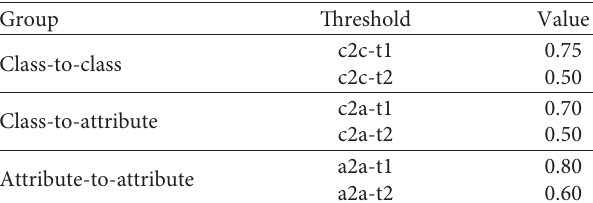
Table 4: Thresholds for judging mapping pairs.